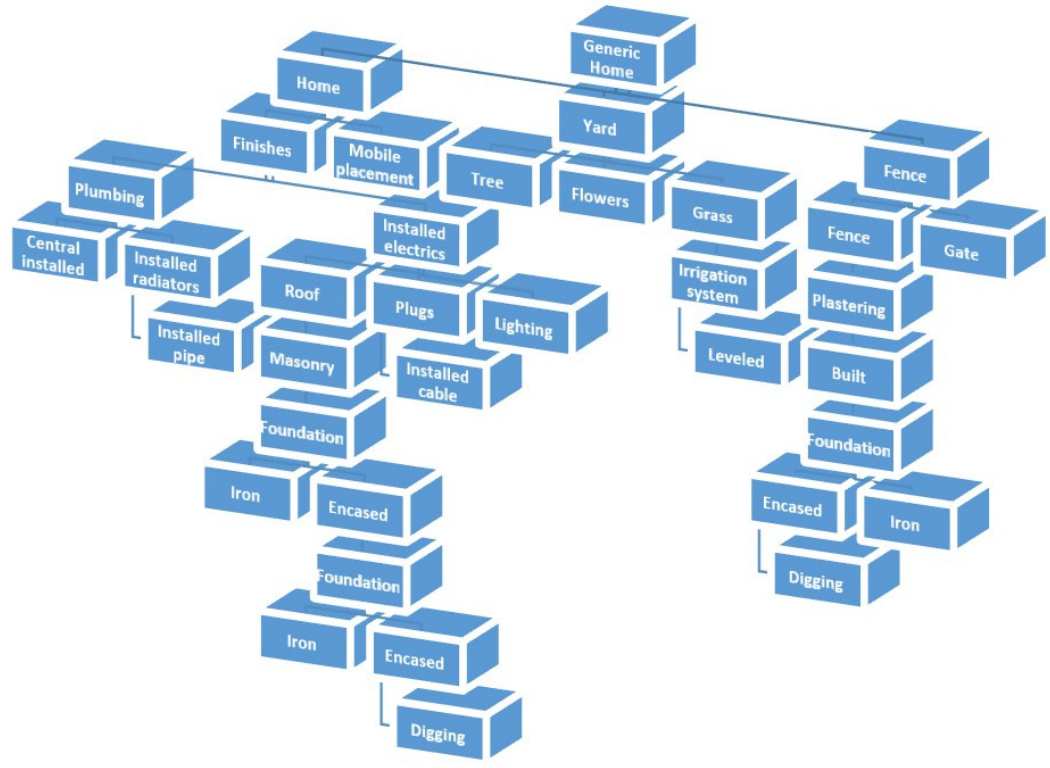
Figure 4. Conceptual diagram of the database dedicated to the Coestim